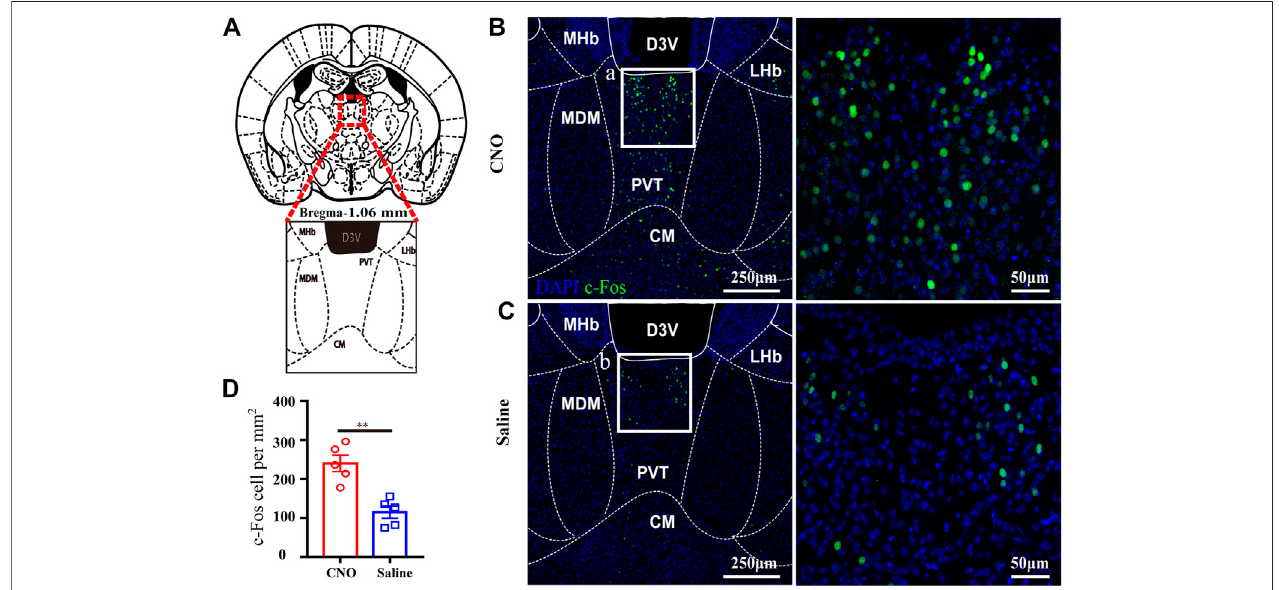
FIGURE 4 | LC TH neurons activation enhances neuronal activity in PVT. (A) Schematic diagram showing the location of the PVT and local structures in mouse. (B,C) Representativephotomicrographsofc-FosexpressioninthePVTinhM3Dq-CNOandhM3Dq-salinemice.Insetswereampli fi edontheright. (D) Quanti fi cationof c-Fos positive nuclei in the PVT of hM3Dq-saline and hM3Dq-CNO mice ( n (cid:1) 5 in each group, two-tailed unpaired t-test, ** p < 0.01). Data shown as means ± SEM.